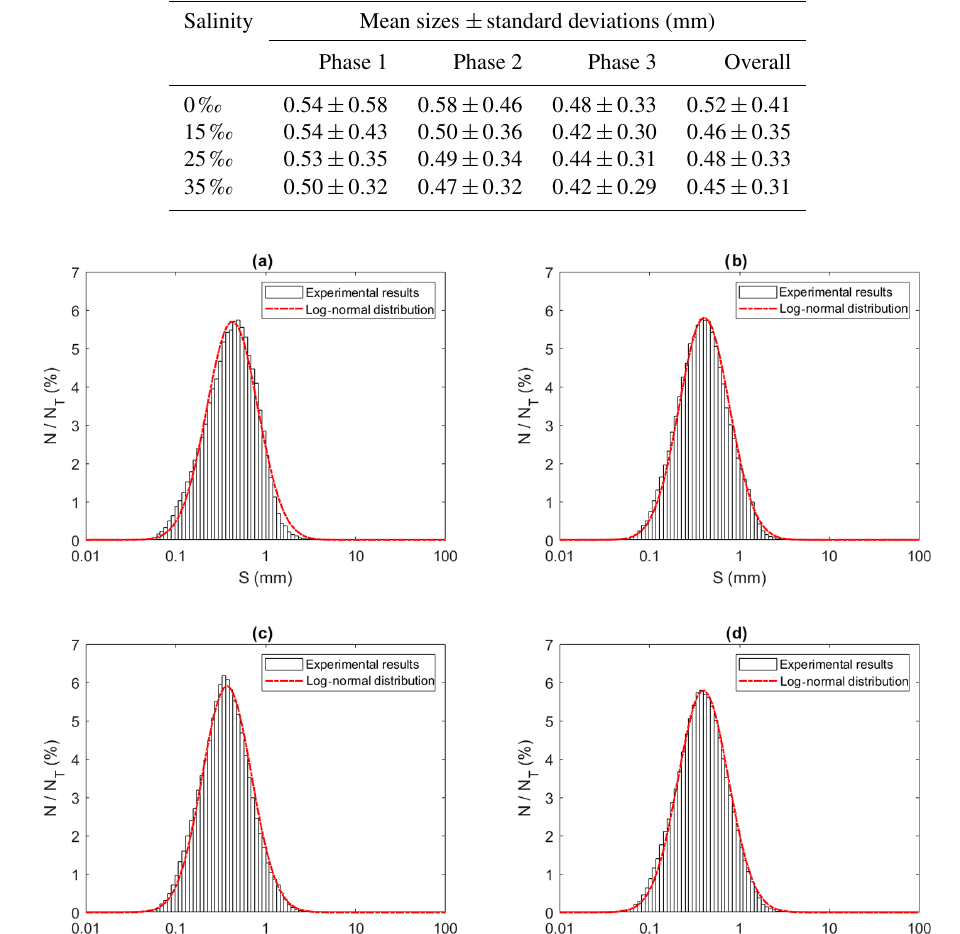
Table 3. Arithmetic mean sizes and corresponding standard deviations of frazil ice particles during different phases at all four salinities.